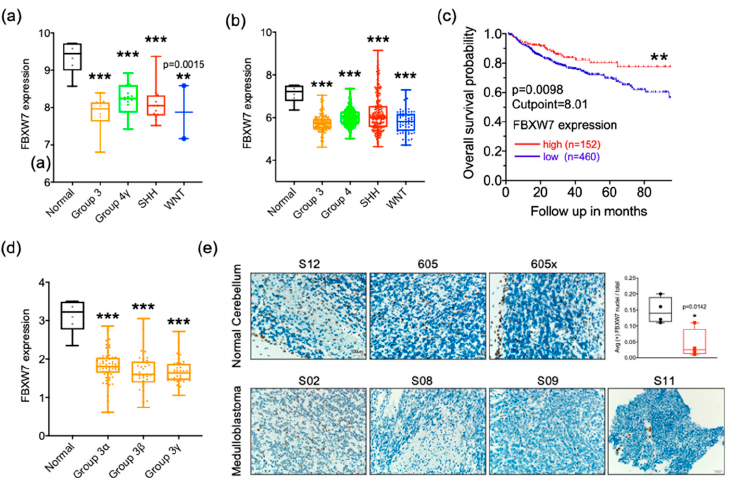
Figure 4. FBXW7 is decreased in medulloblastoma. ( a ) Microarray analysis showing FBXW7 expression in 44 medulloblastoma patient samples. n = 6 in normal, n = 11 in group 3, n = 18 in group 4, n = 13 in the SHH group, and n = 2 in the WNT group. Mean ± SD; ** p < 0.01; *** p < 0.001 (one-way ANOVA). ( b ) Microarray analysis showing FBXW7 expression in 763 medulloblastoma patient samples of Cavalli data. n = 6 in normal, n = 134 in group 3, n = 317 in group 4, n = 211 in the SHH group, and n = 65 in the WNT group. Mean ± SD; ** p < 0.01; *** p < 0.001 (one-way ANOVA). ( c ) Kaplan–Meier plots indicating overall survival in relation to FBXW7 expression in all MB patient populations. ** p < 0.01, Log-rank (Mantel–Cox) test. ( d ) Microarray analysis showing FBXW7 expression in 134 group 3 medulloblastoma patient samples of Cavalli data. n = 61 in group 3 α , n = 35 in group 3 β , and n = 38 in group 3 γ . Mean ± SD; ** p < 0.01; *** p < 0.001 (one-way ANOVA). ( e ) IHC staining of human group 3 medulloblastoma and normal cerebella tissue using a specific antibody for FBXW7. Scale bar: 1 mm. Images shown at 40 × . Mean ± SD; two-tailed student t test, * p <